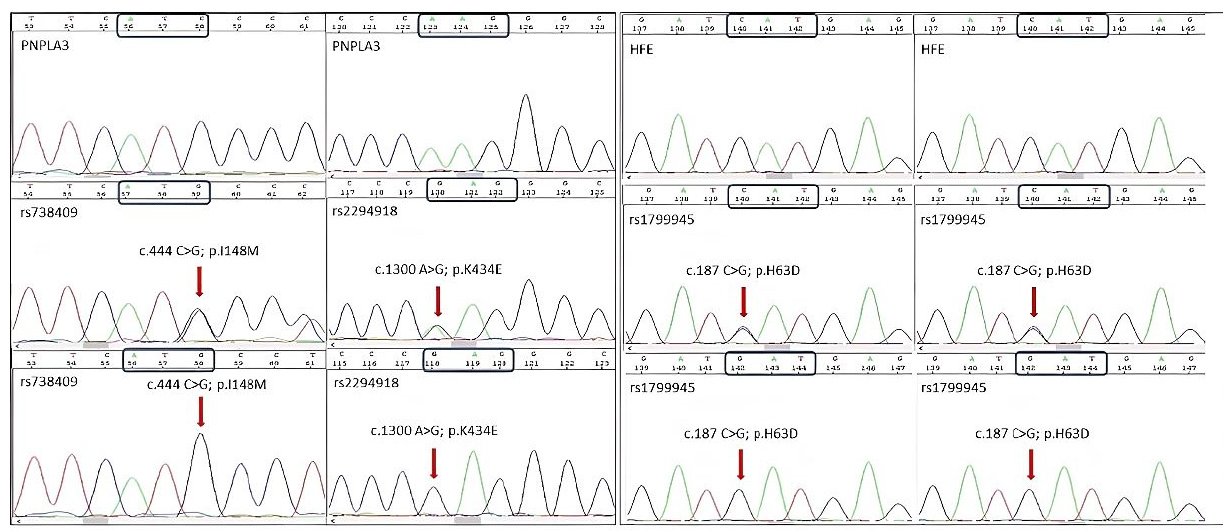
Figure 1. Presentation of Sanger sequencing analysis.